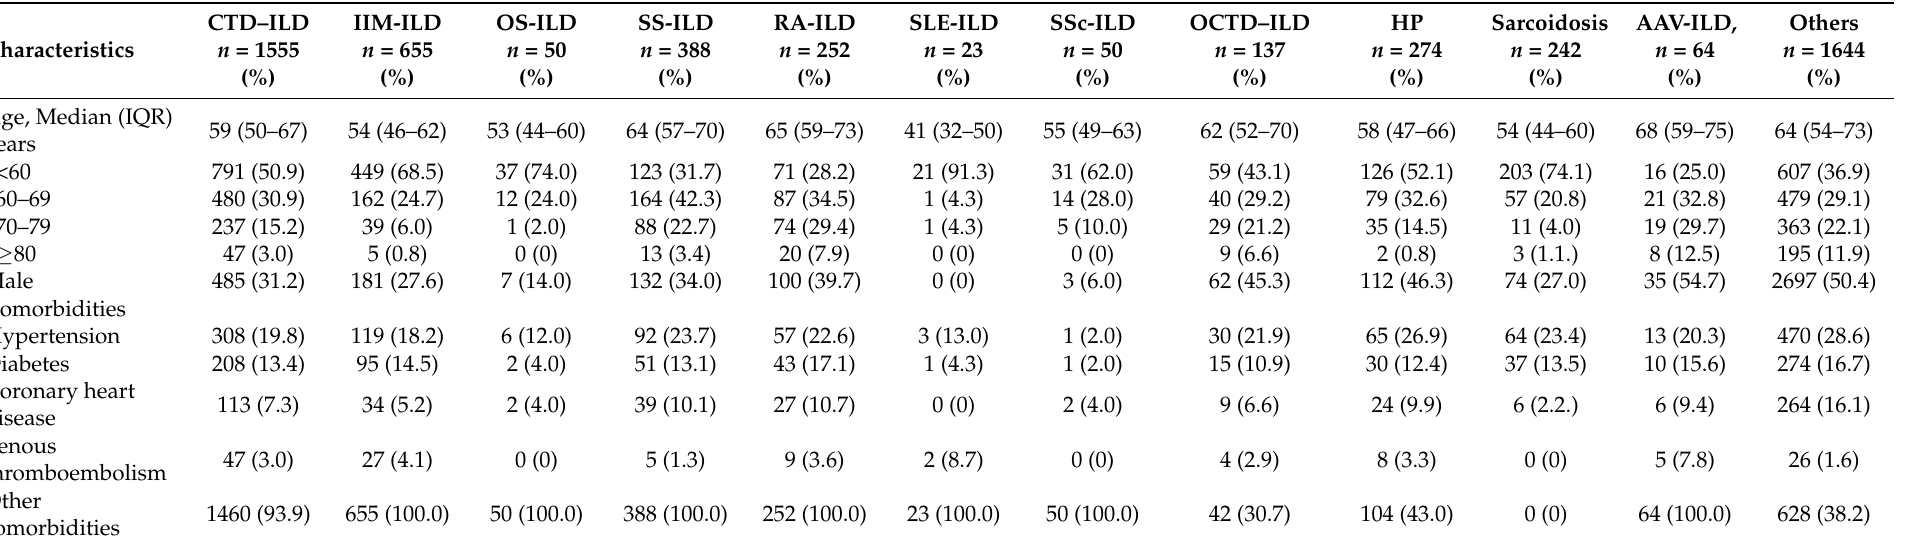
Table 3. Demographic characteristics of ILD (except